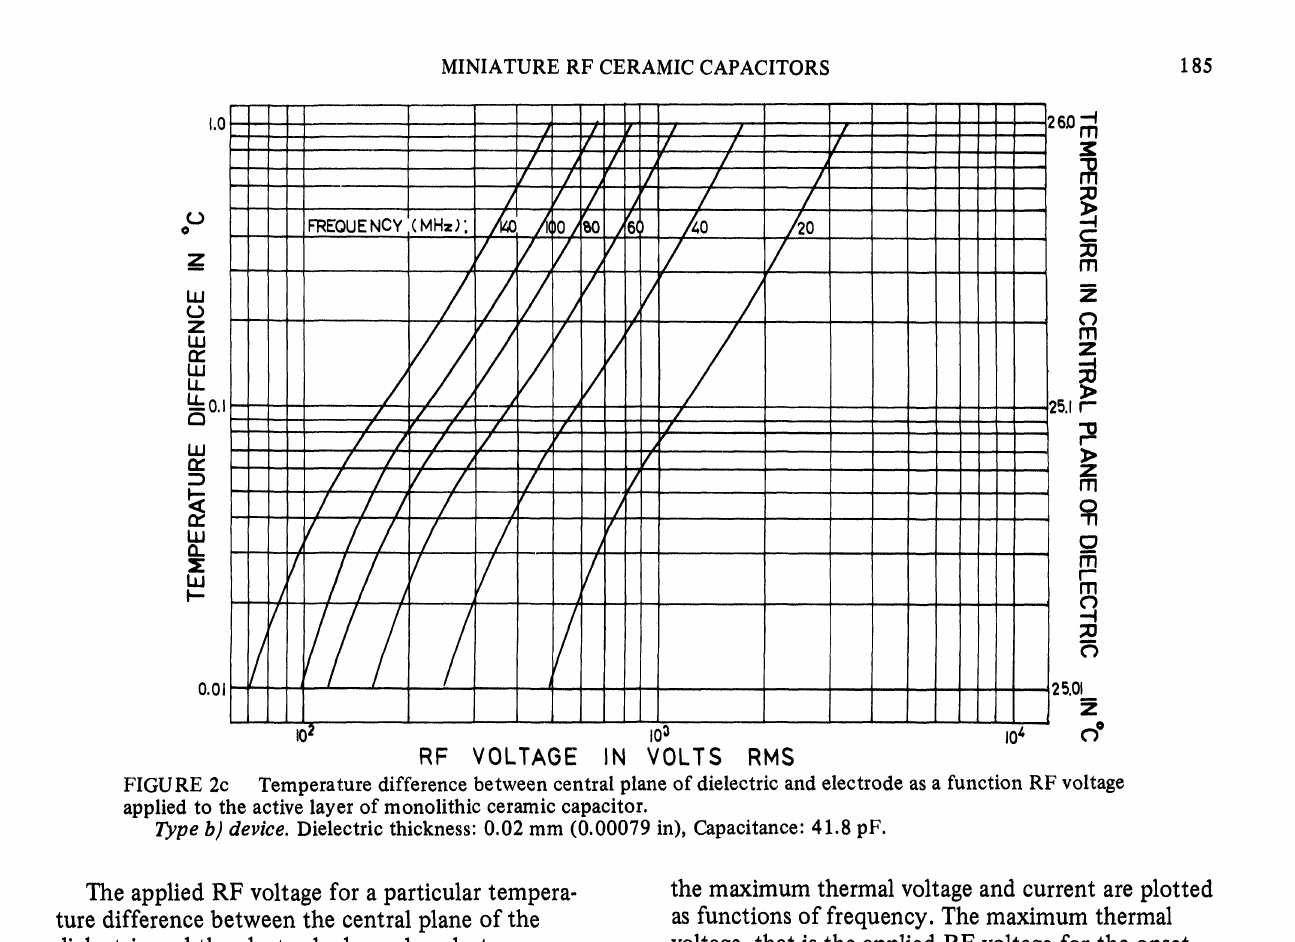
Temperature difference between central plane of dielectric and electrode as a function RF voltage applied to the active layer of monolithic ceramic capacitor. Type b) device. Dielectric thickness: 0.02 mm (0.00079 in), Capacitance: 41.8